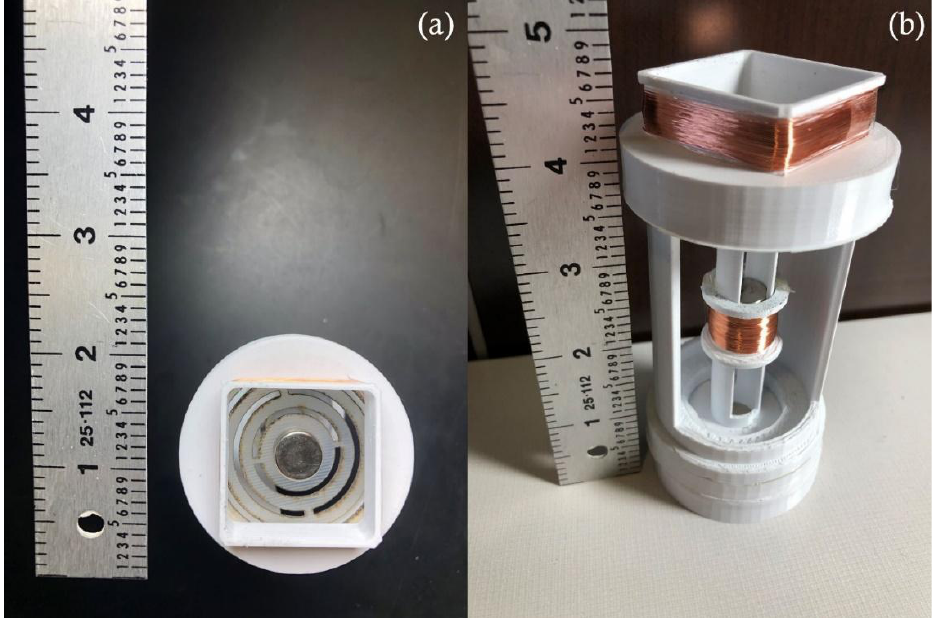
Figure 7. Fully assembled energy harvester-sensor unit next to a scale: ( a ) top view of the unit and ( b ) side view of the unit. Table 1. Specification and details of the fabricated energy harvester-sensor unit.